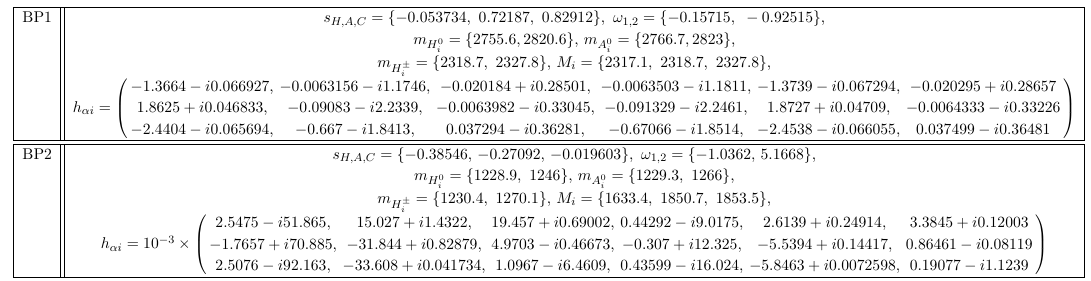
Table 1 . The values of the free parameters for BP1 and BP2. Here, all the masses are given in GeV.